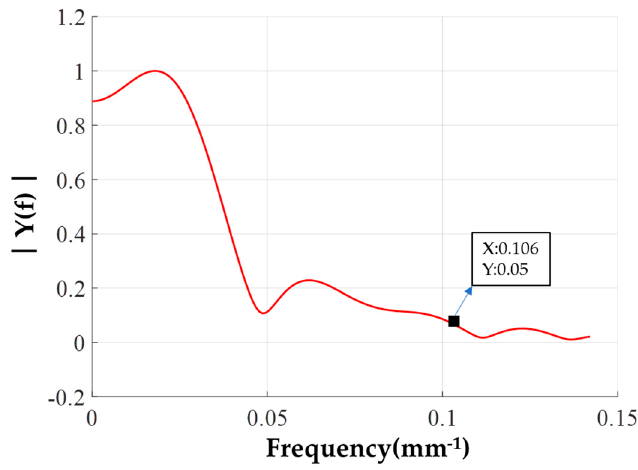
Figure 11. The normalized magnitude spectrum of the removal function contour.